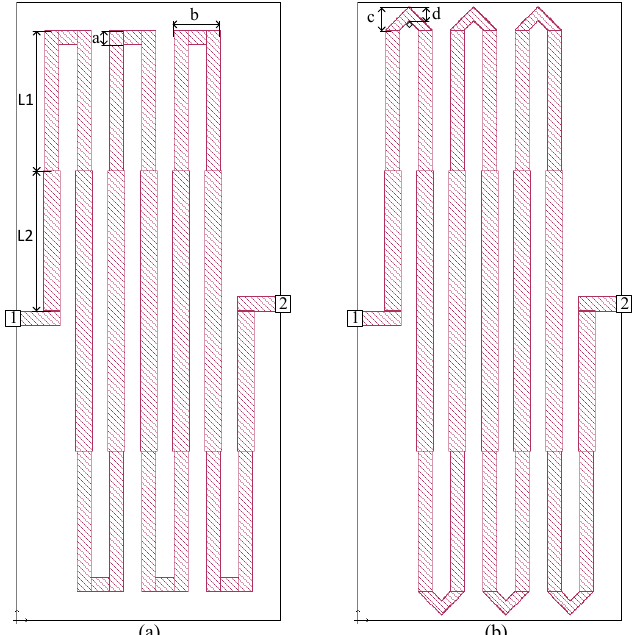
Fig. 2. The meander line models with (a) – traditional shape ( L 1 = 5 mm; L 2 = 5 mm; a = 0.5 mm; b = 1.65 mm), (b) – triangular-shaped ( c = 0.825 mm; d = 0.5 mm; the angle 90°).